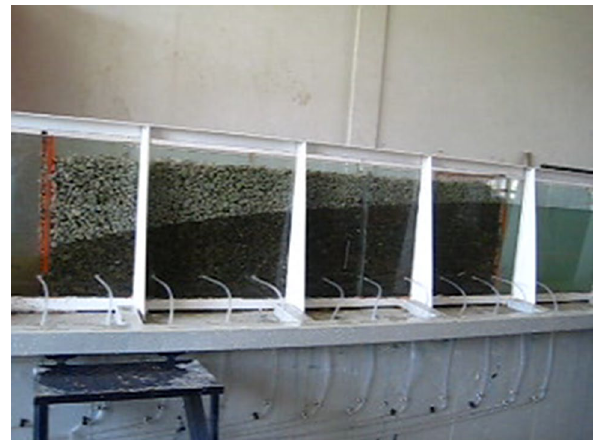
Fig. 2 Experimental setup containing a packed medium through which phreatic line can be seen